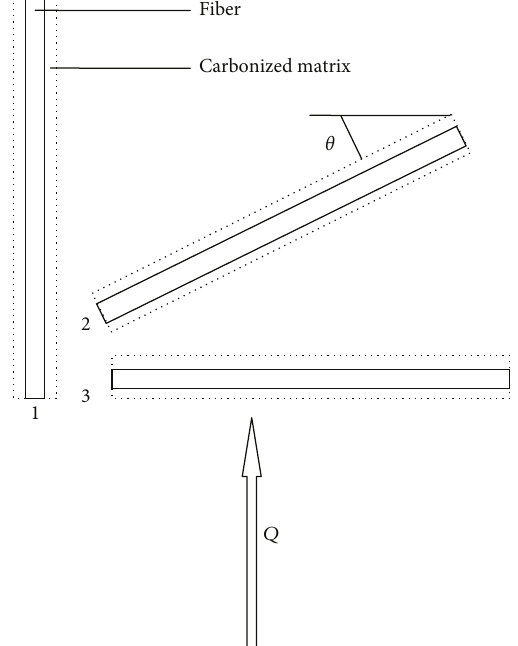
Figure 32: Model of depositing on the fi ber with carbon.